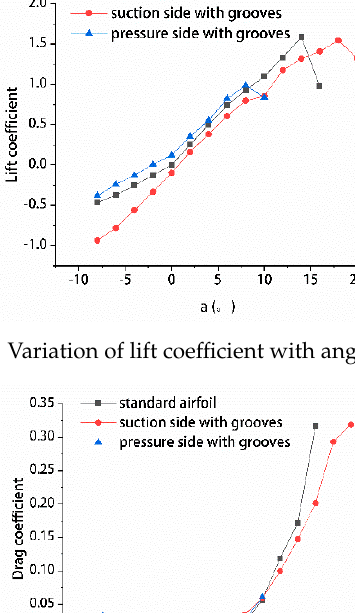
Figure 13. 4° angle of attack, speed distribution of standard NACA0012 airfoil.